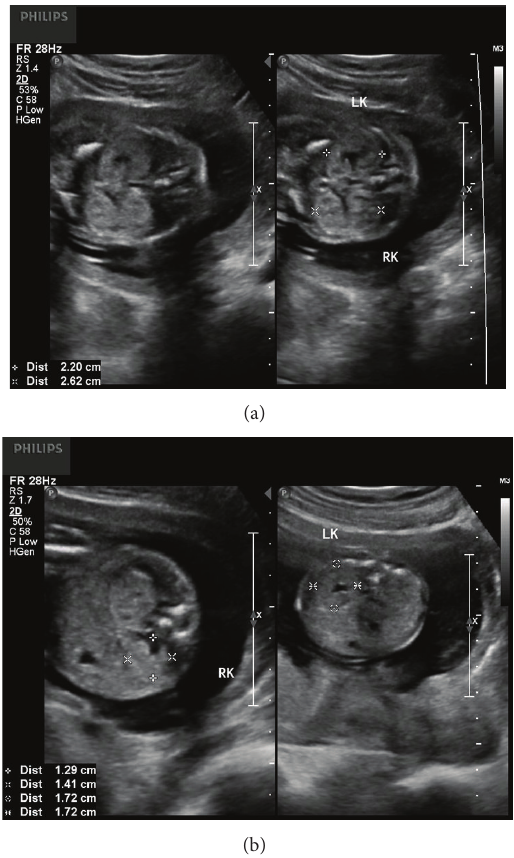
Figure 1: (a) Coronal images of the fetal kidneys at 19 weeks and 4 days of gestation. The kidneys are enlarged and echogenic. (b) Transverse images of the fetal kidneys at 19 weeks and 4 days of gestation. The amniotic fluid level was normal for gestational